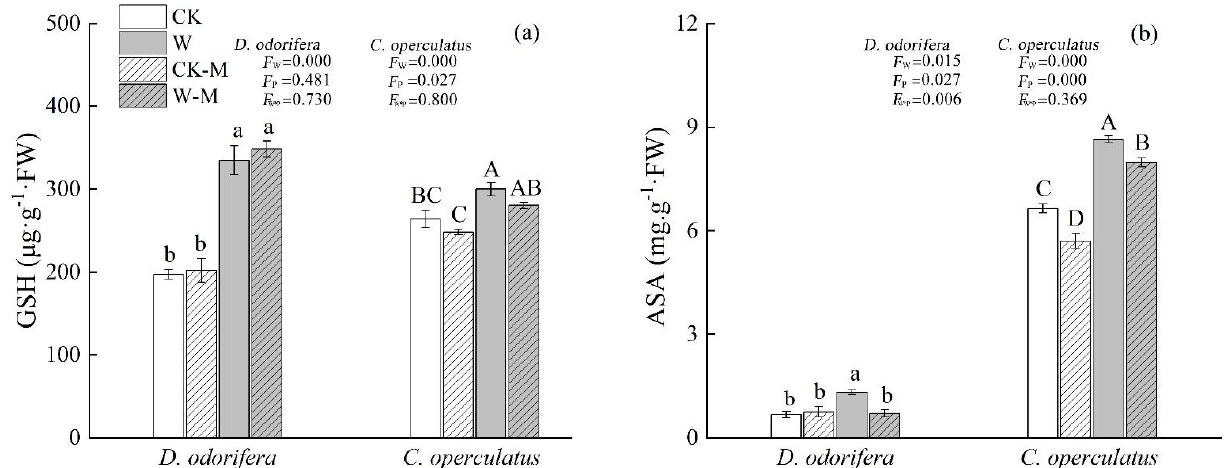
Figure 4. Comparative analyses of the concentrations of GSH ( a ) and AsA ( b ) of C. operculatus and D. odorifera under all treatments. GSH, reduced glutathione; AsA, ascorbic acid. Abbreviations, ex- planations of treatments, data descriptions, and statistics are the same as those shown in Figure 1.